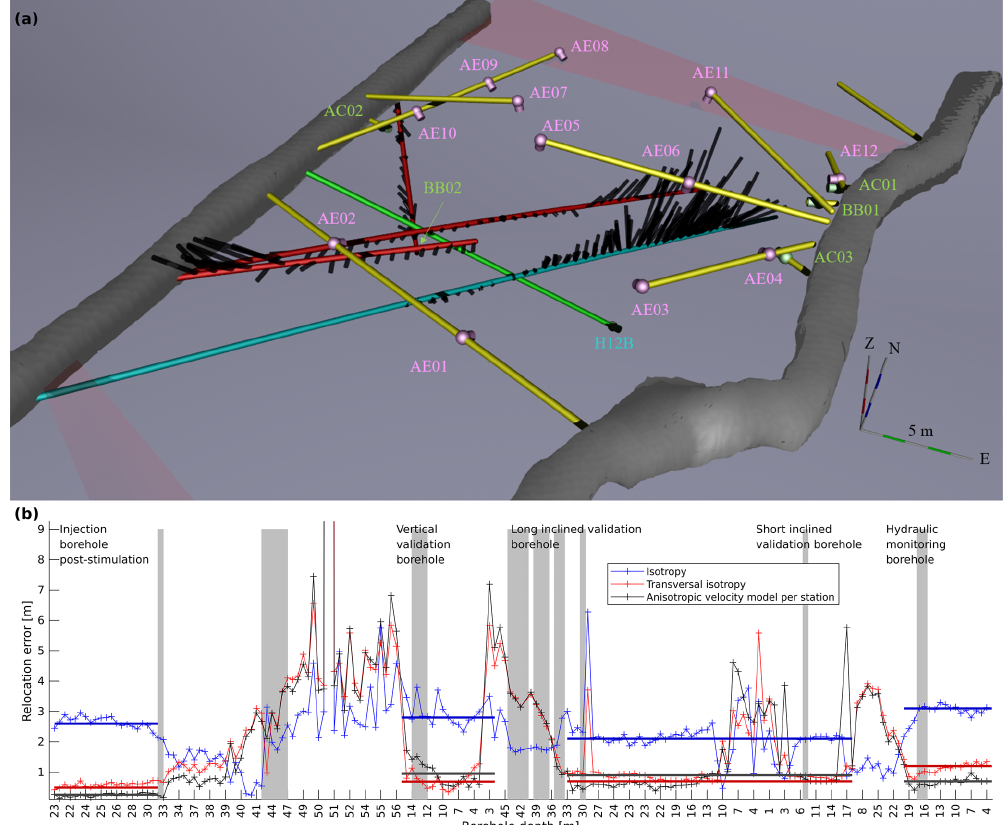
Figure 4. (a) Overview of location uncertainty estimates (black lines) along the injection, vertical and horizontal validation boreholes as estimated from locating known UT measurement positions (see Fig. 3) with the derived best transverse isotropic velocity model per seismic sensor. Note that the location error becomes larger than 1m, where the injection (cyan) and long inclined validation borehole (red) show higher numbers of fractures and more prominent ones (cf. Fig. 2). As shown in more detail in Fig. S4, the estimated location uncertainty is systematically directed upwards, likely a result of the station distribution. Labels refer to AE sensors (pink), accelerometers or broadband sensor (green, with the broadband sensor being moved to a new position during the experiment) and AE hydrophone (blue). Deformation zones (pink zones) that transverse the rock volume between the galleries are also shown. (b) Comparison of location error of known active UT measurement points in the injection, vertical and horizontal validation boreholes as well as the hydraulic monitoring borehole for different velocity models. Relocation errors in black are obtained using the best transverse isotropic velocity model per station, in red from the single transverse isotropic velocity model and in blue from the isotropic velocity model. Coloured horizontal lines represent average relocation errors for the given depth range. Note that the anisotropic velocity model per station minimises the location uncertainties over most depth ranges in all boreholes, except for the vertical validation borehole, where the single transverse isotropy model performs slightly better. The isotropic velocity model performs better at larger borehole depths (where no AE events were observed) and in the wider fracture zones of the injection and long validation boreholes (as indicated by the vertical grey bars, which correspond to the sections shown in Fig.